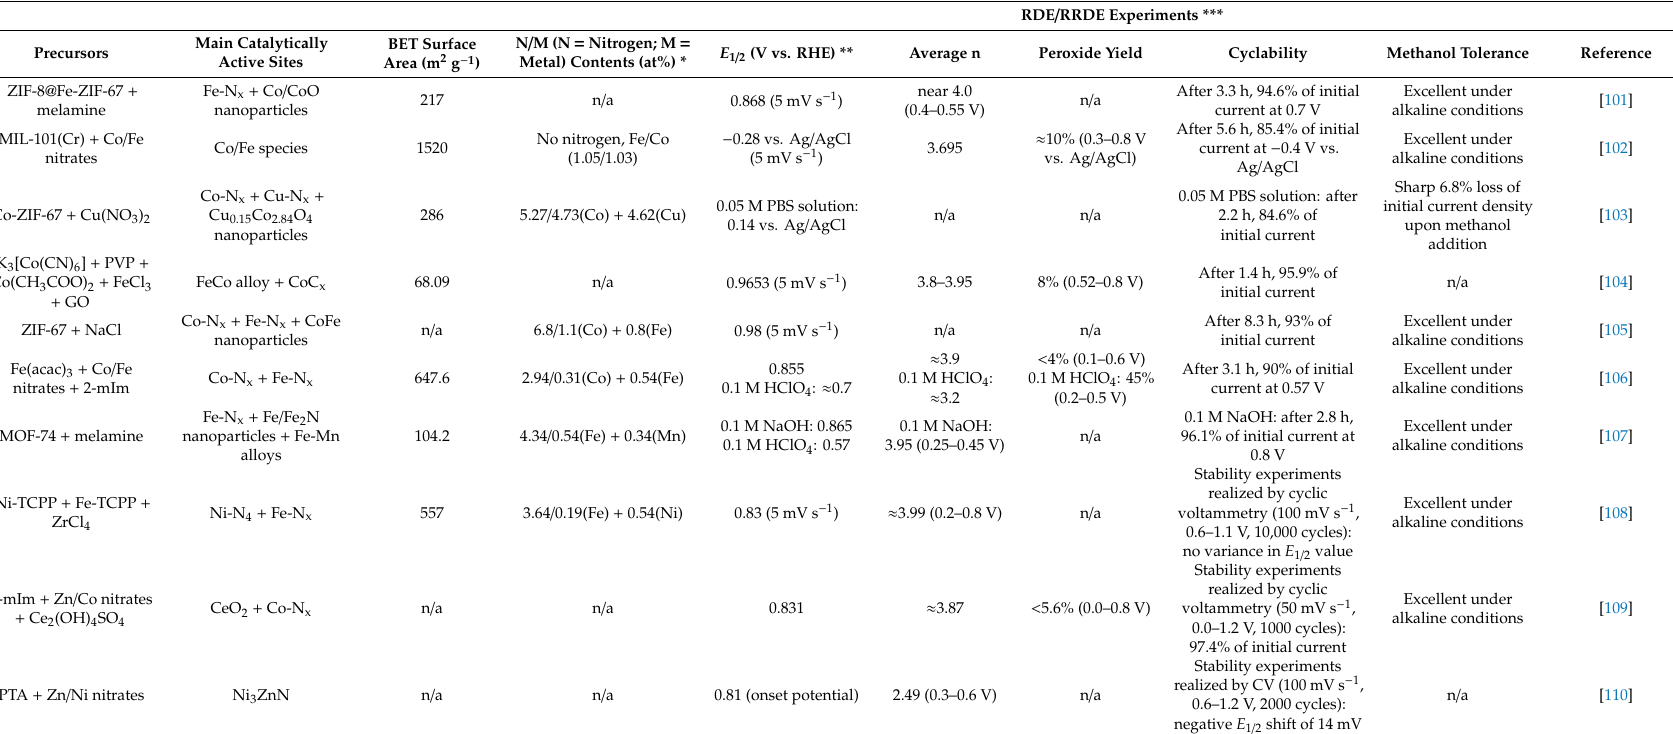
* Sometimes, weight percentage was used, and hence, “wt %” data are provided. More than one metal or heteroatom can be provided depending on the active sites involved. ** Potentials are referenced to RHE except when stated otherwise. The ORR performance were evaluated at 1600 rpm and 10 mV s − 1 except when stated otherwise. *** All the ORR performance values listed were measured in 0.1 M KOH except when stated